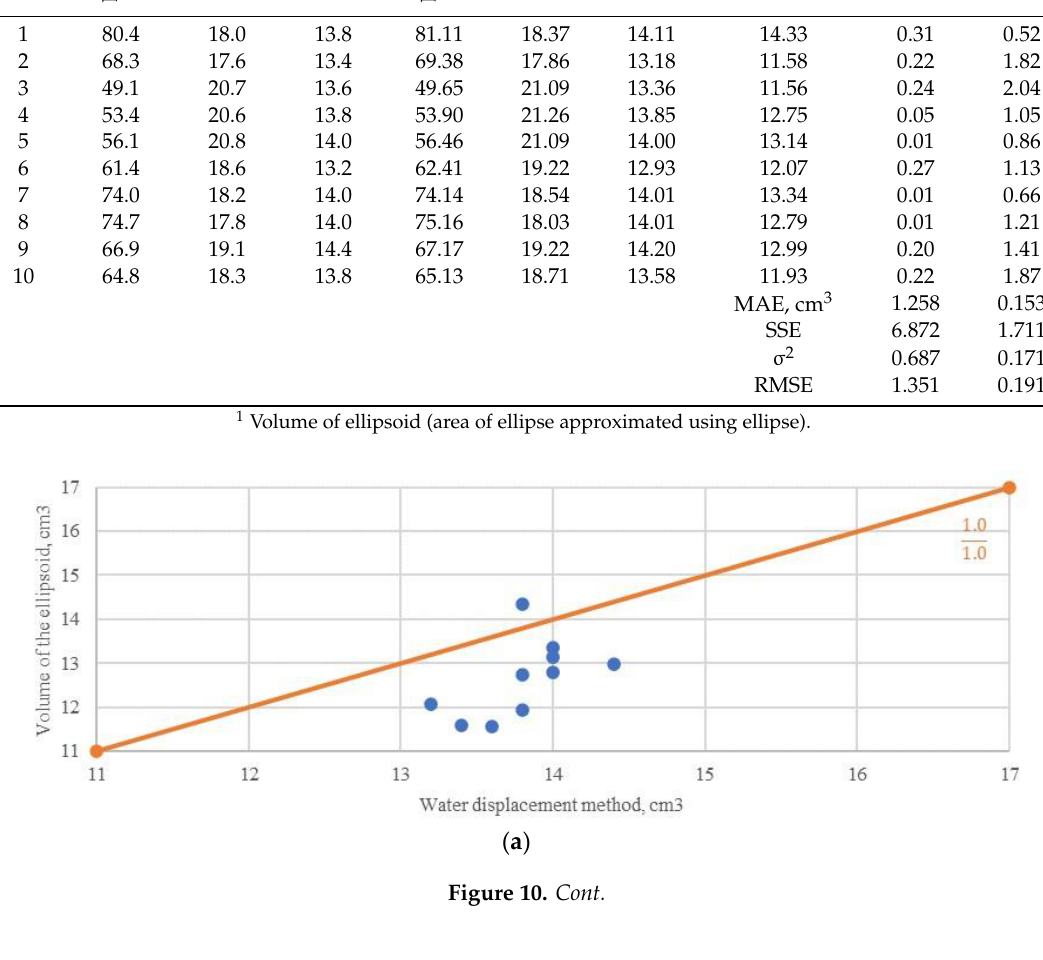
Figure 9. Algorithm for calculation of pellet volume (pellets divided into